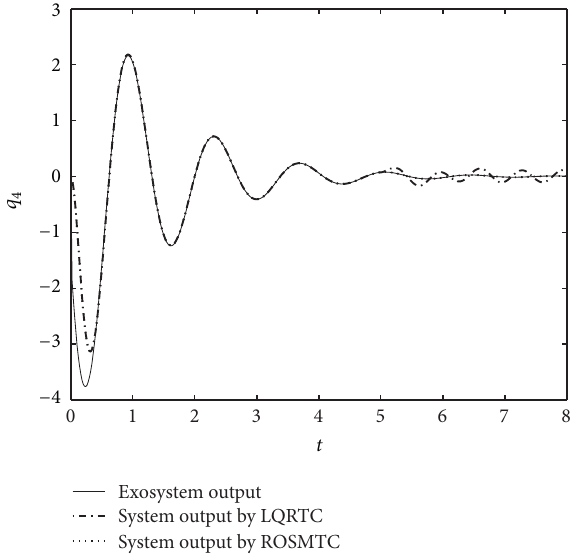
Figure 9: The tracking response curve of the velocity ̇𝑞 2 for link